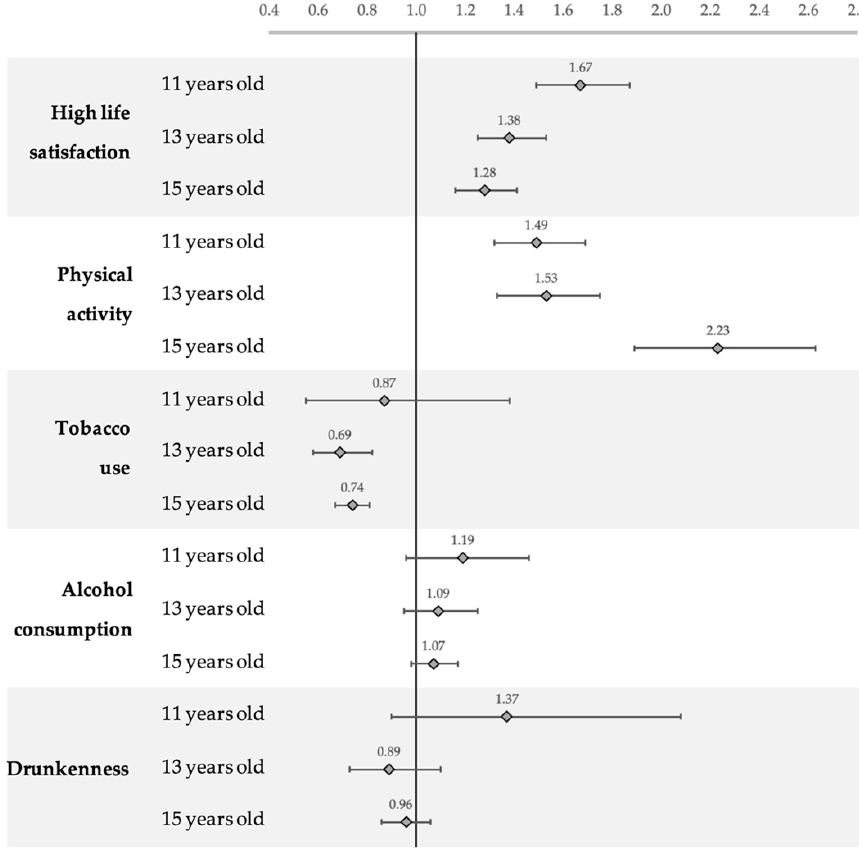
Figure 1. OR and 95% confidence intervals by age group for involvement in organised leisure time activities (OLTA) and study outcomes § . Health Behaviours in School-aged Children (HBSC), Italy 2014. All analyses were mutually adjusted for gender, sociodemographic characteristics and geographic area of residence; youth’ school class-level was used in all models. § —high life satisfaction ( ≧ 6), physical activity (1 h / day), tobacco use at least once a week, alcohol consumption at least once a week, and drunkenness (more than once in life) in 11-, 13- and 15-year-old youth. Tobacco use at least once a week was inversely associated with OLTA participation with significant results in the 13-year-old group (OR = 0.64 in the sport-only group and OR = 0.72 in the mixed group) and in the 15-year-olds (OR = 0.74 in the non-sport group, OR = 0.72 in the sport-only group, and OR = 0.67 in the mixed group). Participation in OLTAs was associated with alcohol consumption only in the mixed group with a significant slight increase in the odds in 13- and 15-year-olds (OR = 1.26, 95% CI 1.1; 1.5 for 13-year-old and OR = 1.19, 95% CI 1.1; 1.3 for 15-year-old youths). Finally, lower odds of repeated drunkenness were only found among 13-year-olds in the sport-only group (OR = 0.75, 95% CI 0.6; 0.98) and among 15-year-olds in the non-sport group (OR = 0.82, 95% CI 0.7; 0.9). Opposite results were observed for the non-sport group (for the 27) 11-year-olds, with an OR of 1.95 (95% CI